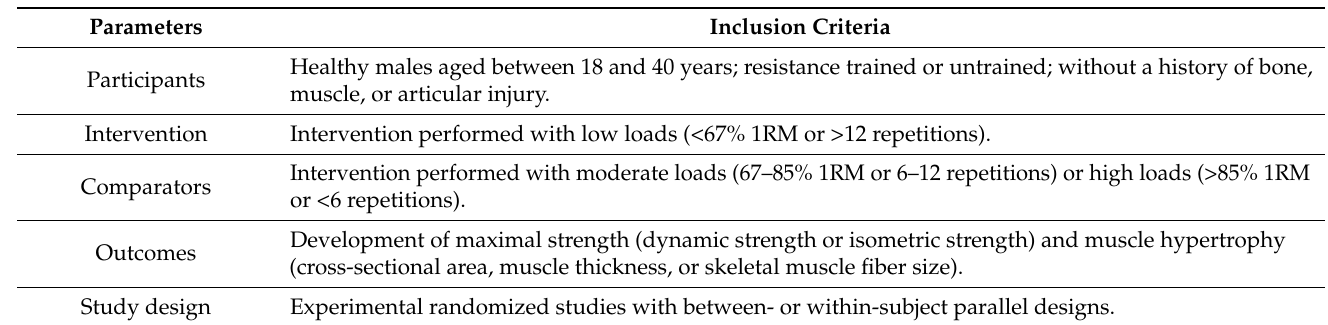
Table 1. PICOS eligibility criteria for the inclusion of studies in the systematic review. Parameters Inclusion Criteria Healthy males aged between 18 and 40 years; resistance trained or untrained; without a history of bone, Participants muscle, or articular injury. Intervention Comparators Development of maximal strength (dynamic strength or isometric strength) and muscle hypertrophy Outcomes (cross-sectional area, muscle thickness, or skeletal muscle fiber size). Study design Experimental randomized studies with between- or within-subject parallel